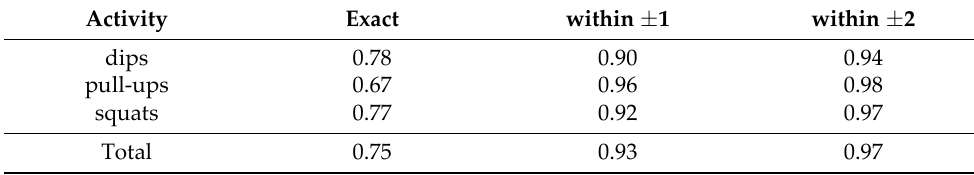
Table 12. Accuracies of repetition